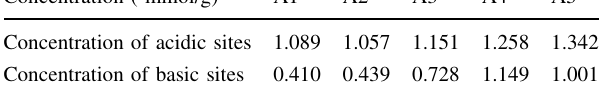
Table 3 Concentration of surface acidic and basic sites of the acti- vated cokes Concentration ( mmol/g) A1